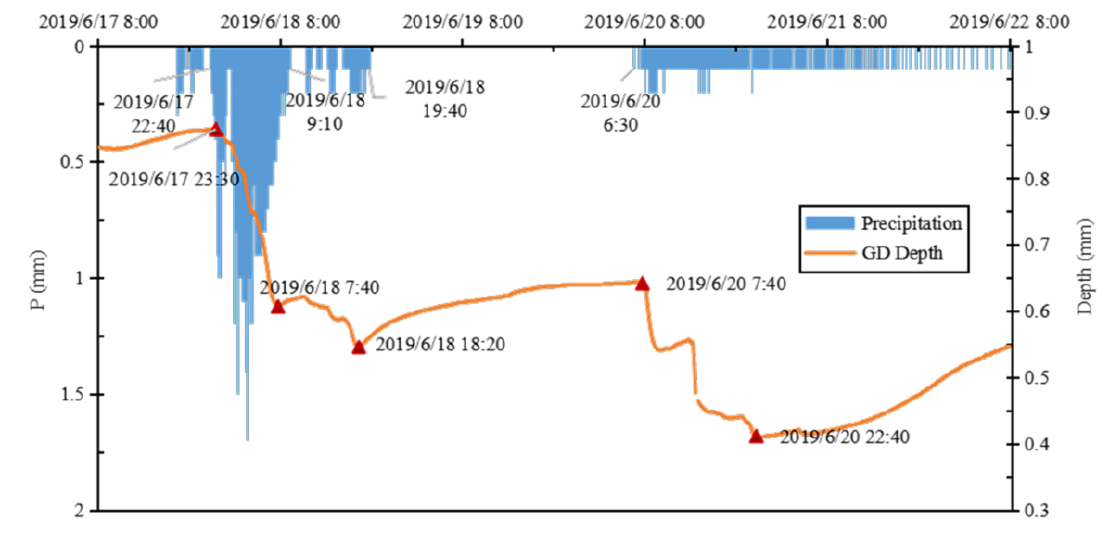
Figure 6. Response of groundwater level to precipitation from 2019/6/17 8:00 to 2019/6/20 8:00.